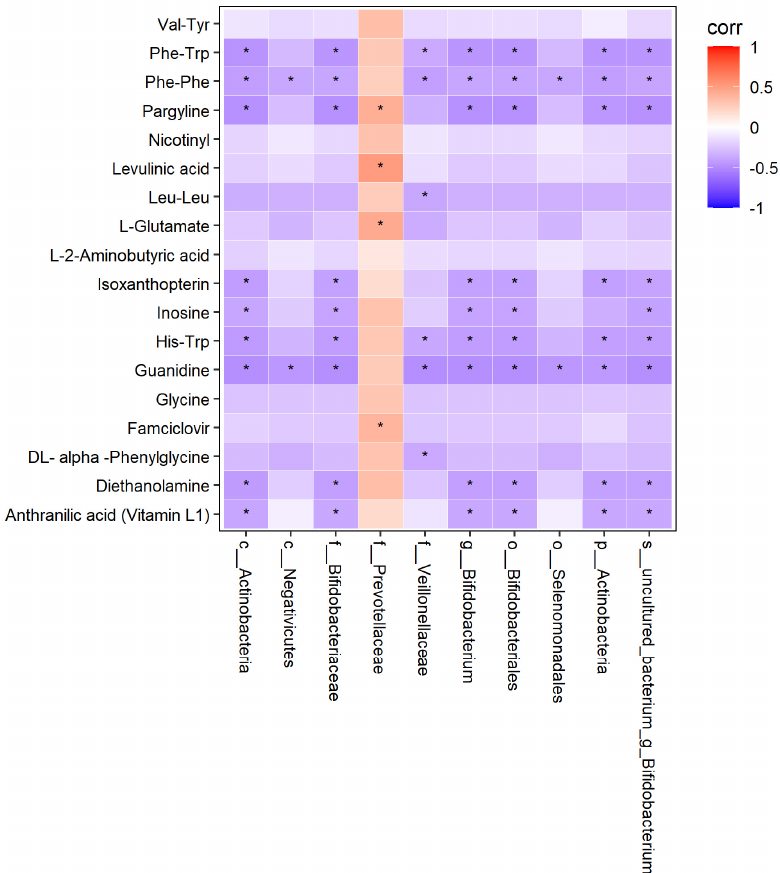
26 Figure 26. Correlation thermodynamic diagram in positive ion mode. In the figure, red (corr = 1), blue (corr = − 1), white (corr = 0). The data with correlation P value less than 0.05 were marked with “*” in the figure. The ordinate was metabonomics differential metabolites, and the abscissa was 16S differential flora.